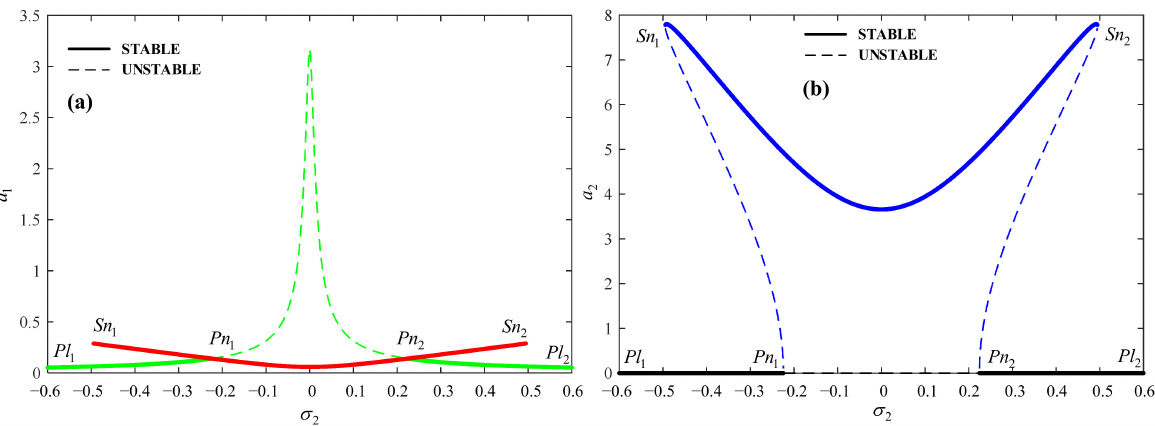
Figure 6. Effect of σ 2 on frequency-response curves of ( a ) flexible manipulator and ( b ) vibration absorber (when σ 1 = 0).